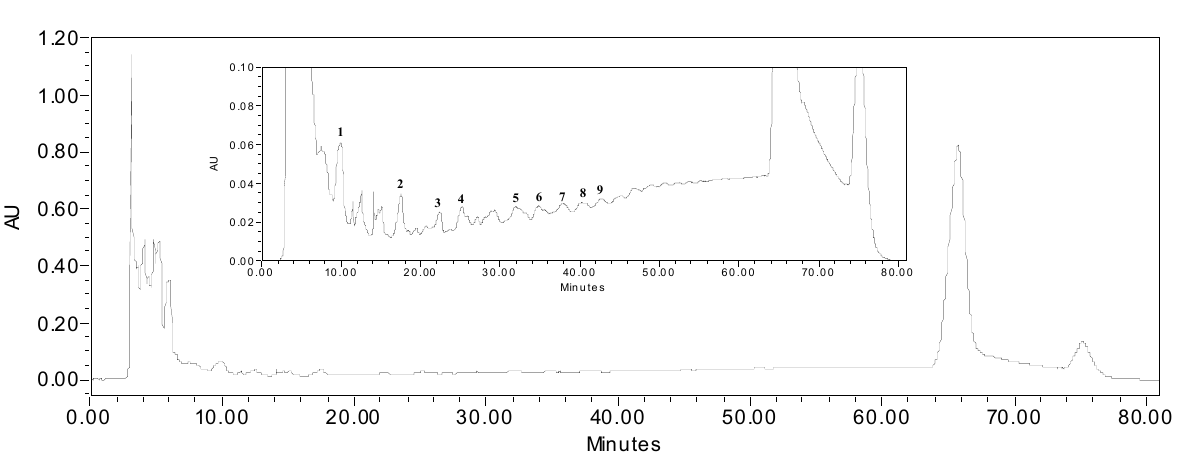
Figure 3. HPLC chromatogram of proanthocyanidins in P. multiflorum Thunb. The identities of the compounds are listed in Table